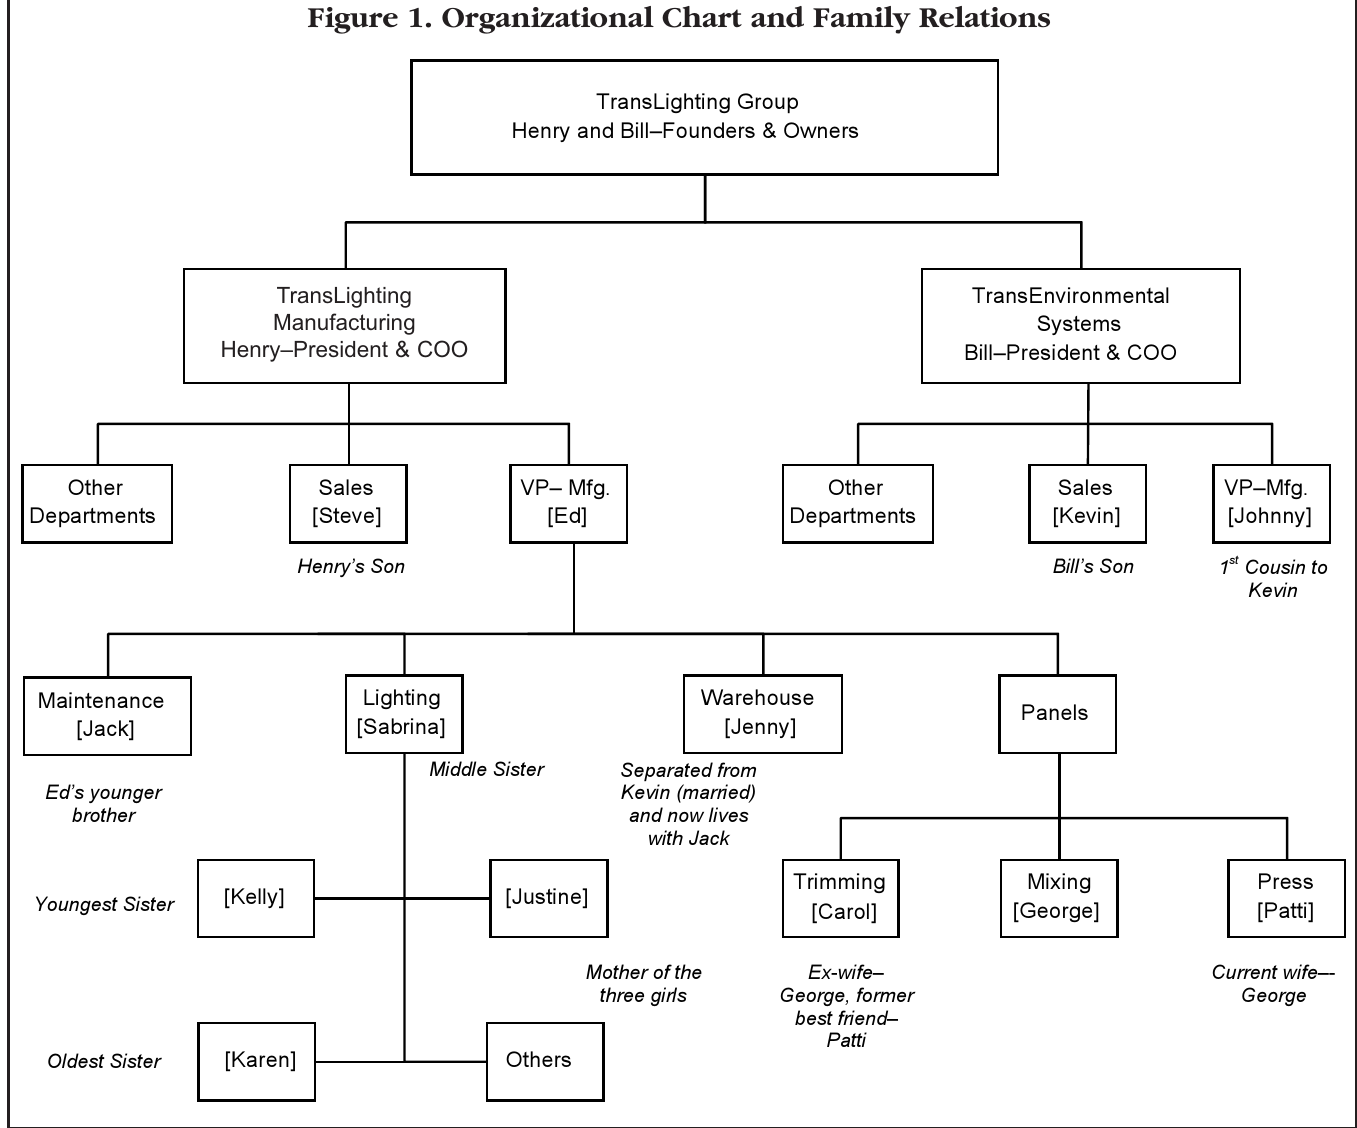
Figure 1. Organizational Chart and Family